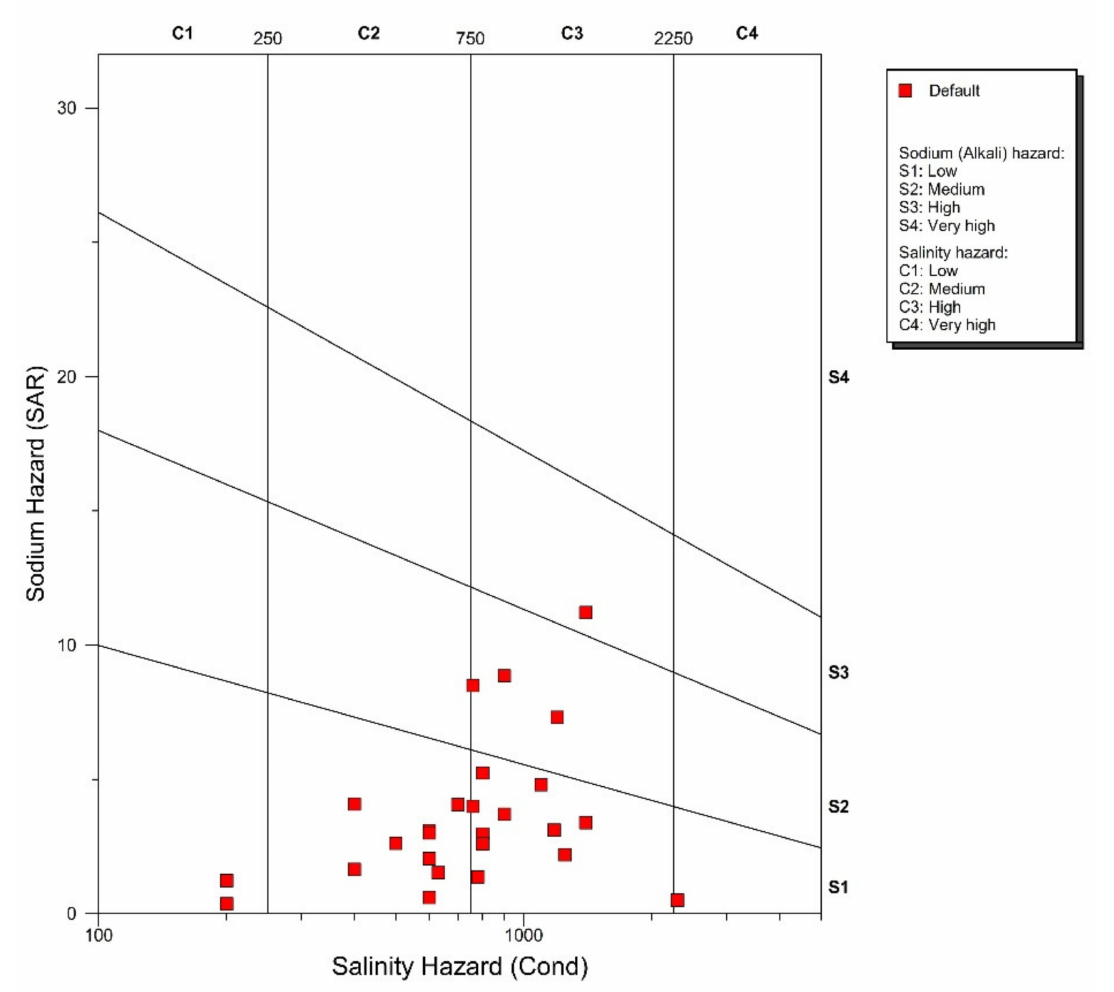
Figure 7. US salinity classification of groundwater for irrigation in the study area. The percent sodium (Na%) method introduced by Richards (1954) and L.V Wilcox (1958) was used to describe and comprehend the major chemical characteristics of ground- water, as its suitability for irrigation is dependent on water mineralization and its impact on plants and soil. Excess sodium in water produces unfortunate impacts from changing soil properties. When sodium-rich irrigation water is used, the clay particles absorb Na + in the soil and remove the Mg 2+ and Ca 2+ ions from the lattice. Furthermore, this substitution of Na + for Ca 2+ and Mg 2+ in soil from water can influence permeability and decrease internal drainage within the soil [52]. As a result, air and water movement are restricted in wet conditions, and such soils become hard when dry. The chemical quality of groundwater samples was studied from plots of EC plotted against the percentage of Na on the Wilcox diagram (Figure 8). The Wilcox diagram illustrates that 2 groundwater samples were not suitable, and the rest of the samples can be used for